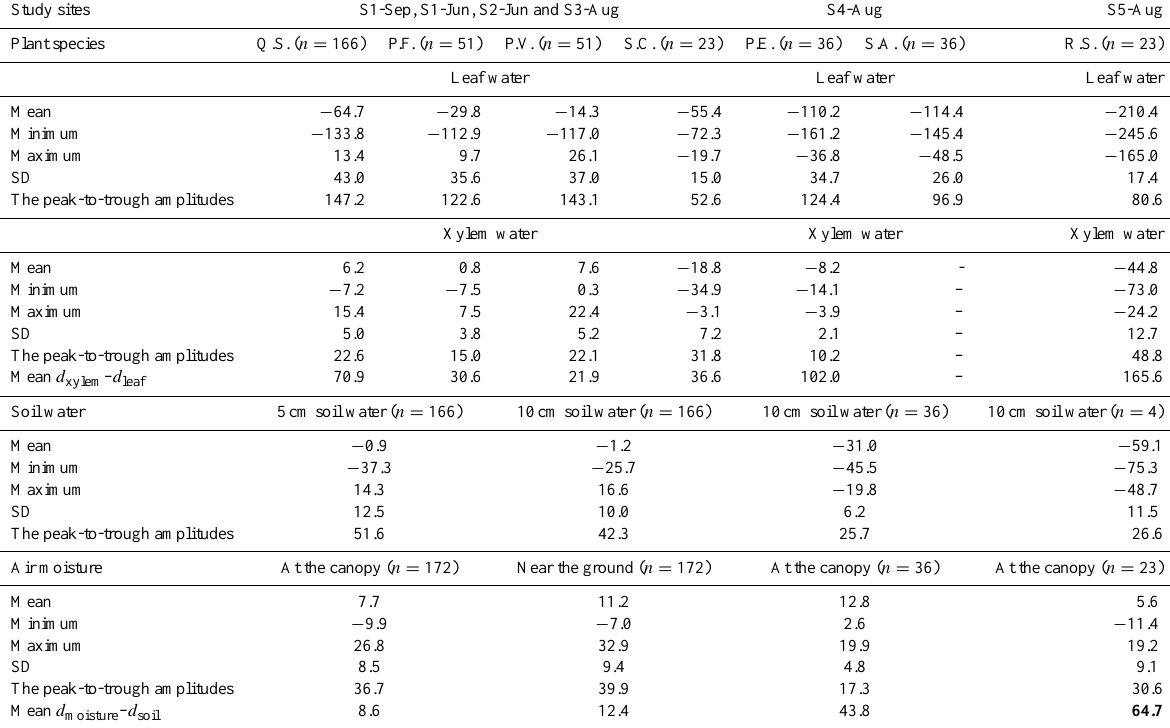
Table 4. Spatial and temporal variations in the d-excess (‰) of each water pool in the Heihe River basin. The numbers in parentheses indicate the number of samples. The location ID and the abbreviations of plant Latin names are the same as in Tables 2 and 3.